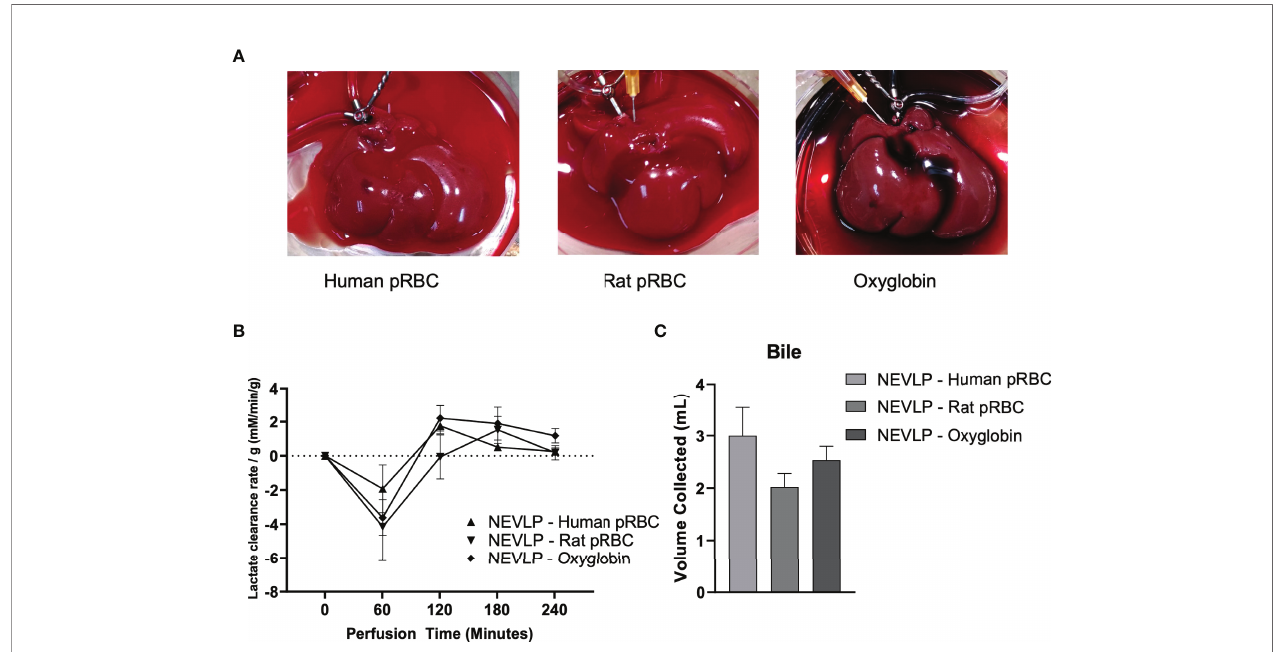
FIGURE 2 | Normothermic machine liver preservation. Livers in the normothermic ex vivo liver perfusion arms underwent 4 h of normothermic preservation with human pRBC, rat packed red blood cells, or Oxyglobin as the oxygen carrier. Oxygen saturation of the perfusate was maintained at >95% throughout the duration of each perfusion, and no signi fi cance was found in portal vein pressure between groups (data not shown). Perfusate samples were collected once hourly for assessment of lactate, liver damage, and cytokine concentrations. (A) Representative livers undergoing perfusion from each treatment group. (B) Lactate clearance of livers undergoing perfusion with different oxygen carriers. (C) Bile was collected from the bile duct during perfusion. Due to technical failures with bile duct cannulation (2 in the human pRBC, 1 in the rat pRBC, and 2 in the Oxyglobin groups), bile production data consist of n = 4 for human pRBC and n = 6 for rat pRBC and Oxyglobin groups. Data are shown as mean ± SEM. pRBC, packed red blood cells; NEVLP, normothermic ex vivo liver